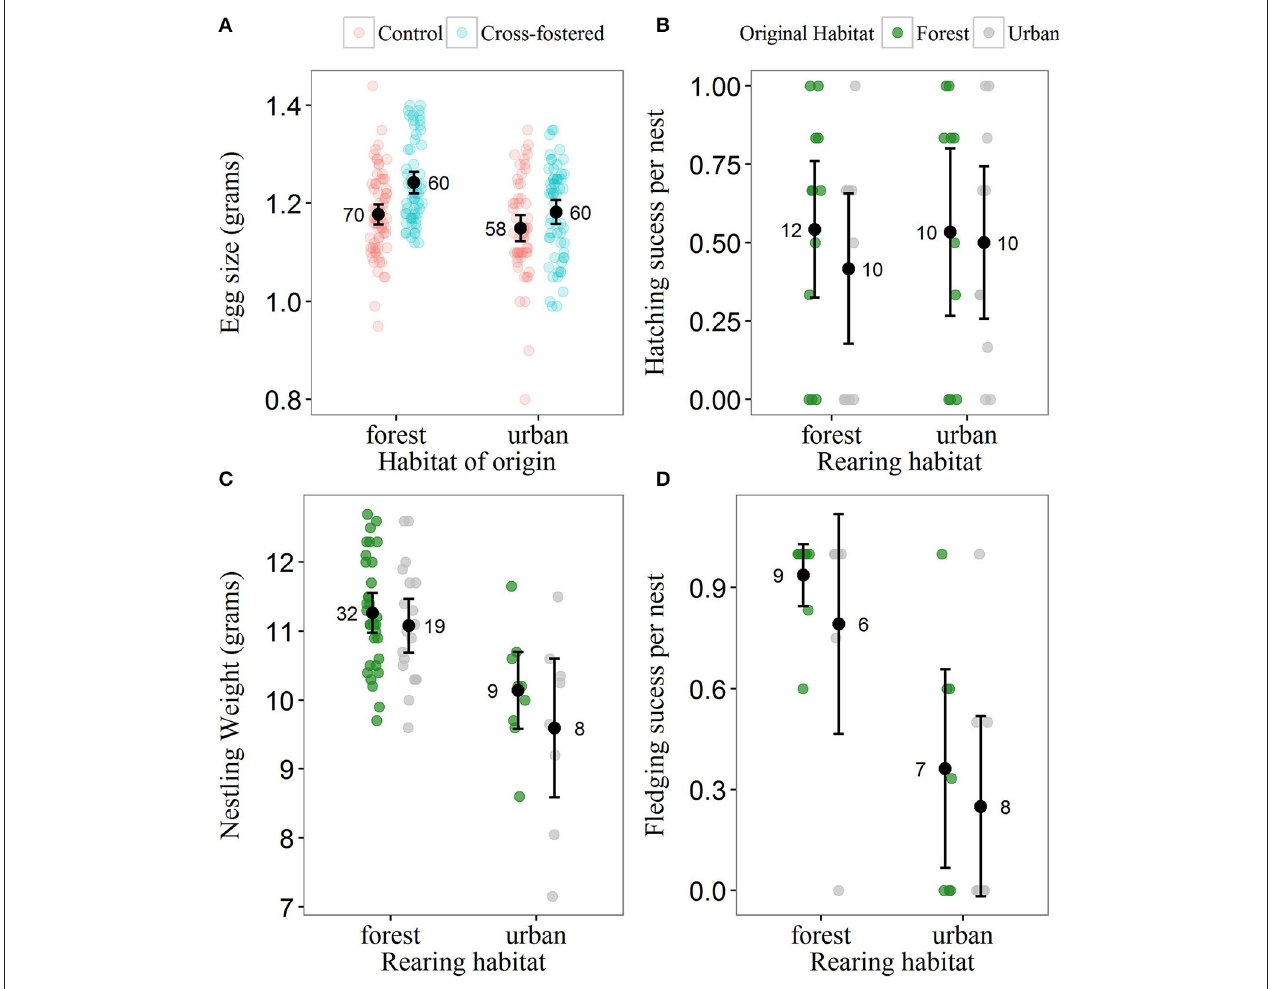
FIGURE 3 | Breeding investment and breeding success for urban and forest blue tits. (A) Egg size across original habitats (urban and forest) and experimental groups. Cross-fostered eggs were swapped between sites and were reared in the fostering habitat; control eggs were swapped between nests within site. In the urban rearing habitat, forest- and urban-originated eggs differed in weight, whereas in the forest rearing habitat eggs in both experimental groups had similar weights. (B) Hatching success, (C) fledging success, and (D) weight of 13-day old nestlings across original and rearing habitats. Black dots illustrate raw data mean values and black bars illustrate ± 2 standard errors. Raw data points are represented as partially transparent dots (see legend). Sample sizes are given beside mean